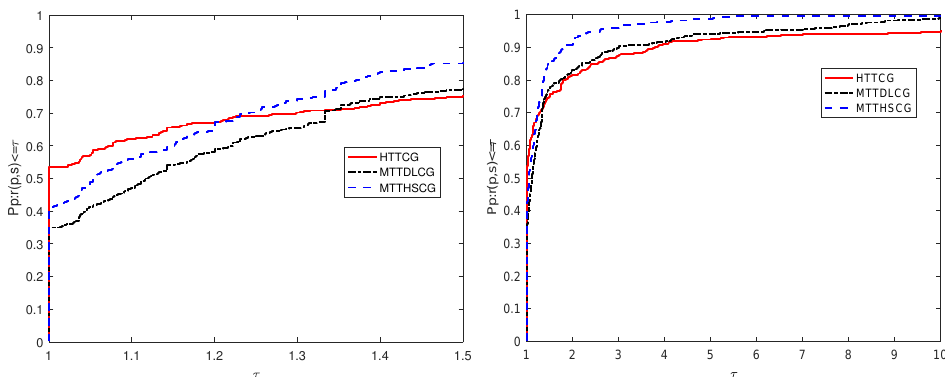
Figure 1. Performance profiles of the numerical results for these methods in number of iterations case.